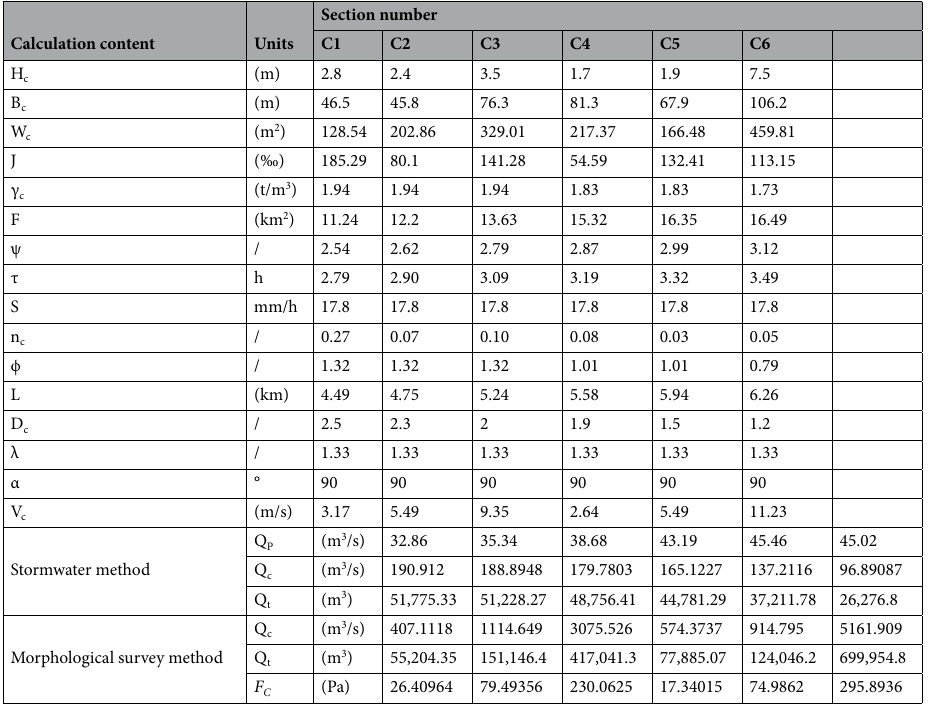
Table 5. Calculation results of related